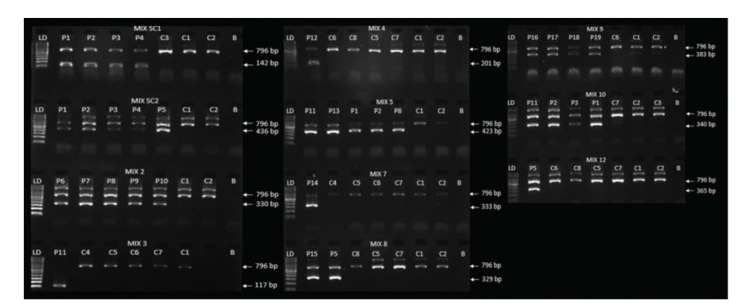
Band pattern of positive and negative samples for HLA-B*27 allelic variants for all standardized PCR-SSP. P: HLA-B*27 positive sample; C: HLA-B*27 negative sample; B: blank. Step ladder (LD): 100 base pairs (bp). Internal control: 796 bp. Band size of each mix: mix SC1: 142 bp; mix SC2: 436 bp; mix 2: 330 bp; mix 3: 117 bp; mix 4: 201 bp; mix 5: 423 bp; mix 7: 333 bp; mix 8: 329 bp; mix 9: 383 bp; mix 10: 340 bp; mix 12: 365 bp.